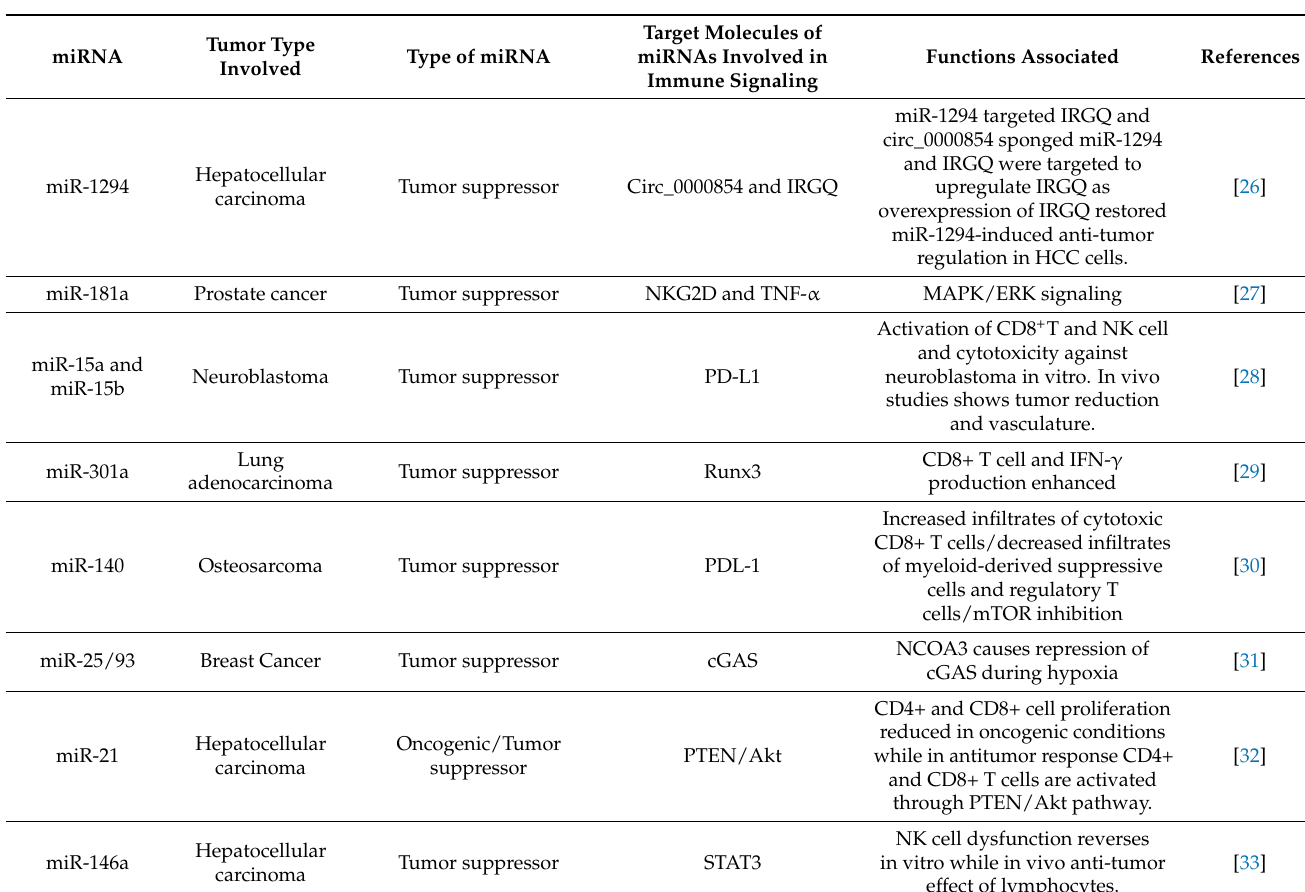
Table 1. Different tumor suppressor/ oncogenic miRNAs, their associated target molecules, and function with respect to specific solid